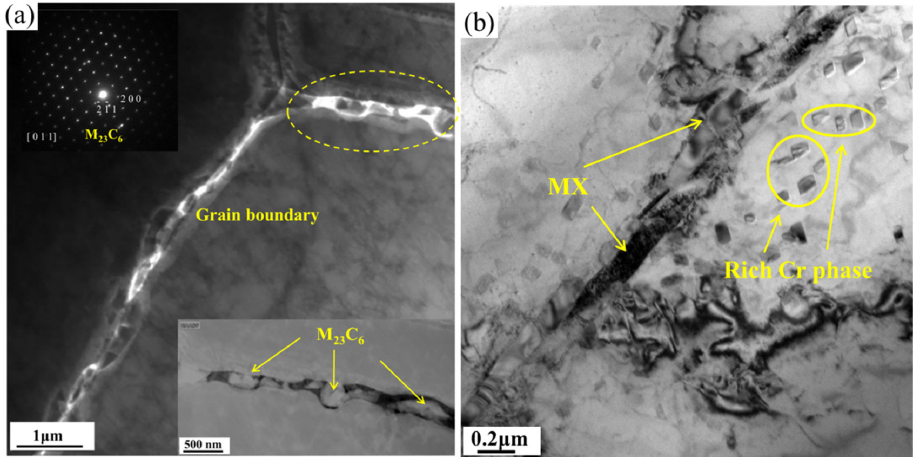
Figure 10. TEM characterization of the creep sample in HAZ ( a ) triple grain boundary ( b ) twin grain boundary.